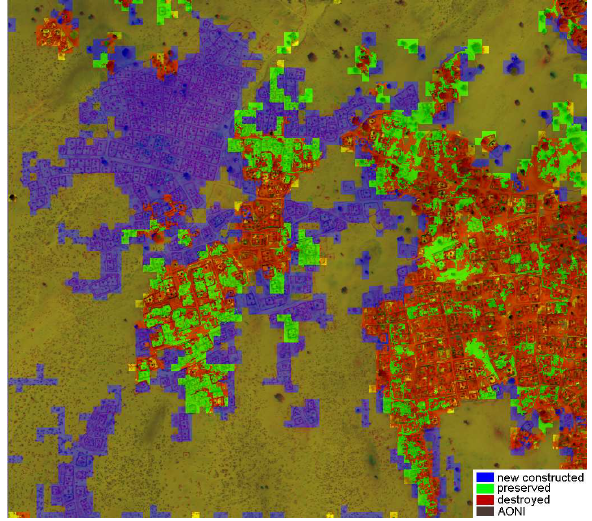
Figure 4. Results of the Change Detection Analysis for